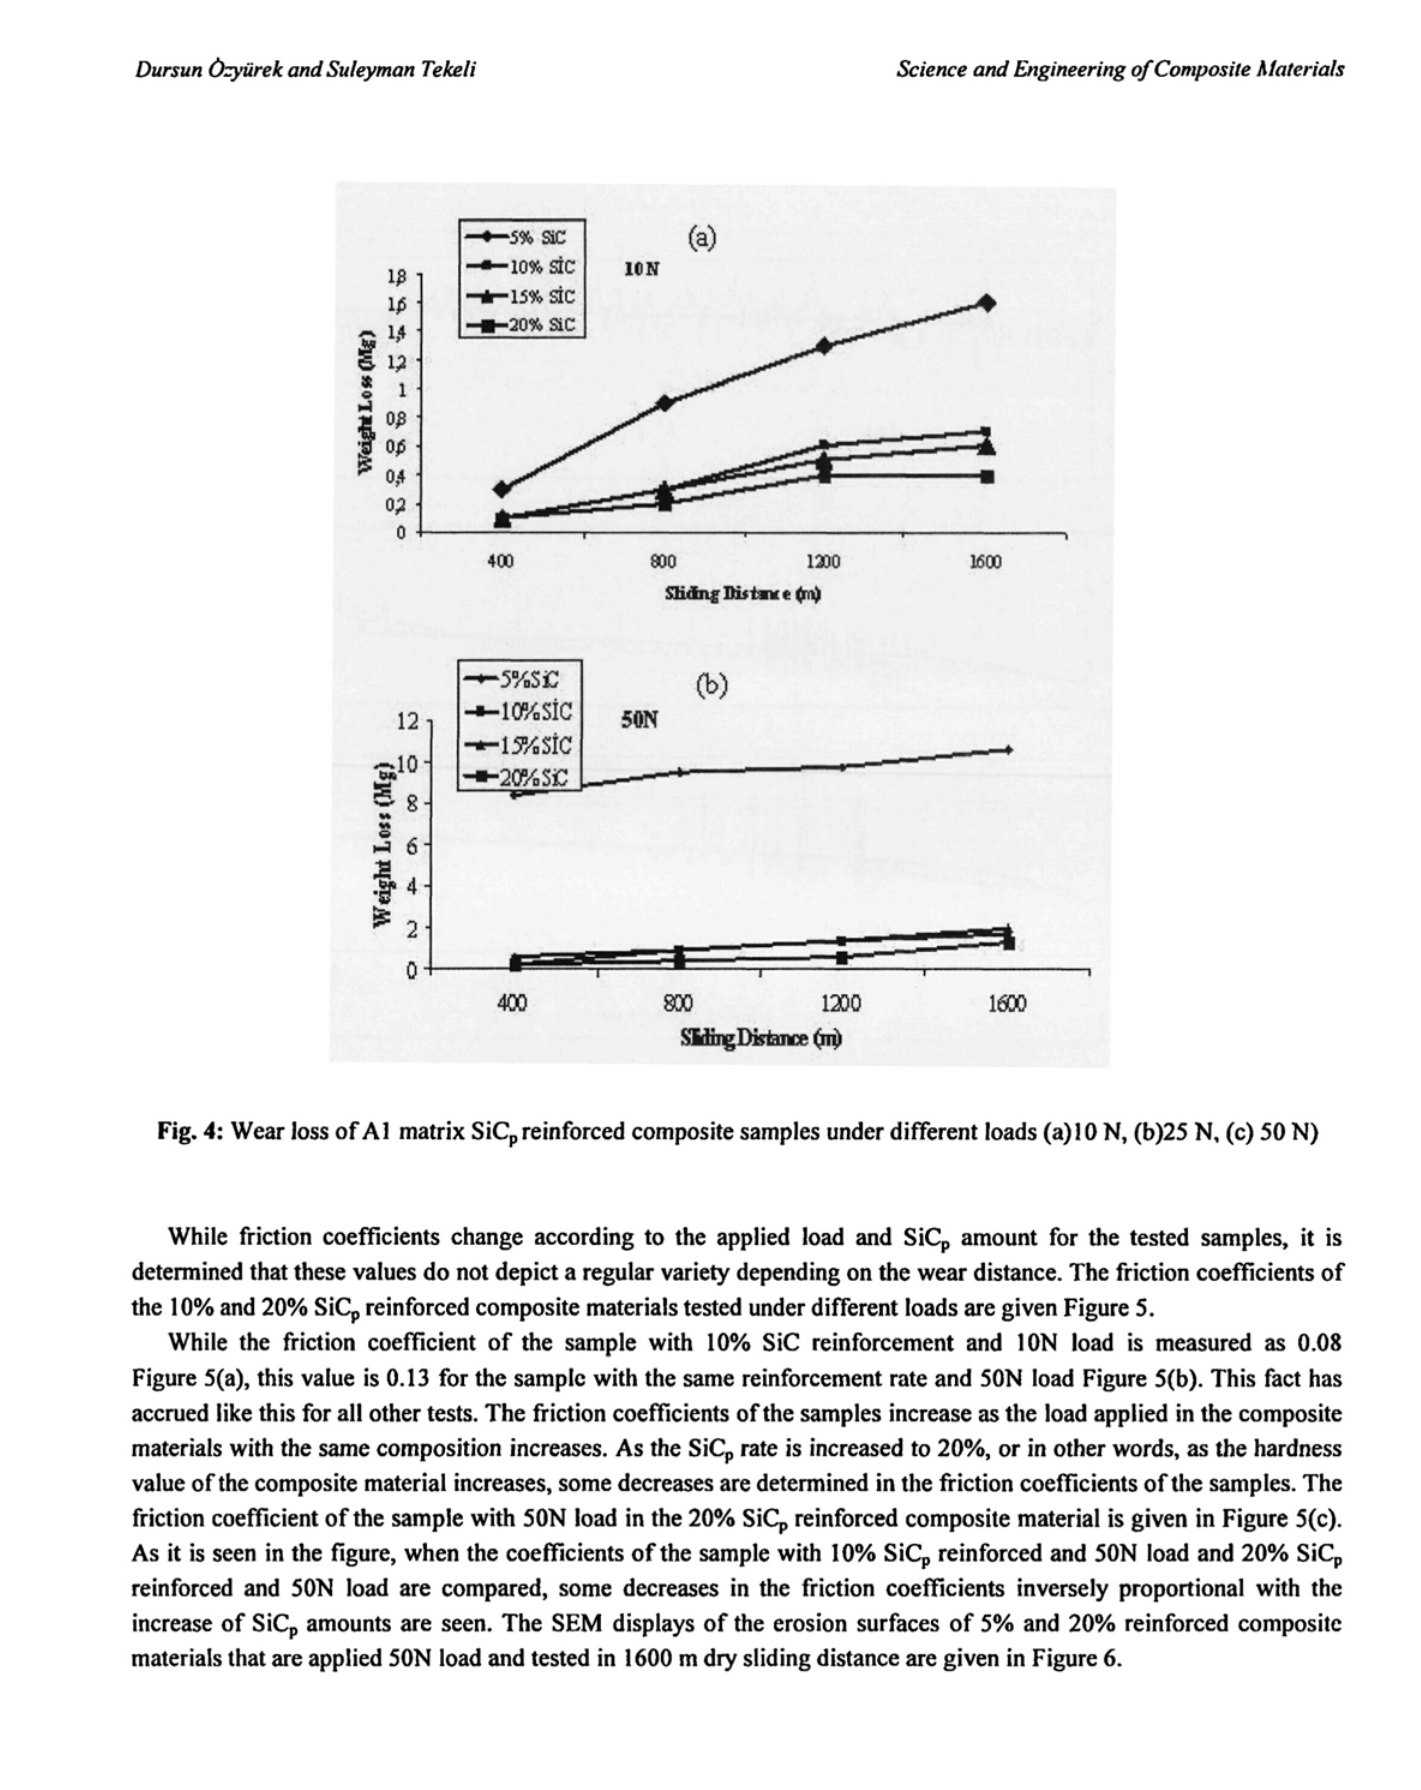
materials with the same composition increases. As the SiC rate is increased to 20%, or in other words, as the hardness p value of the composite material increases, some decreases are determined in the friction coefficients of the samples. The friction coefficient of the sample with SON load in the 20% SiC reinforced composite material is given in Figure 5(c). p As it is seen in the figure, when the coefficients of the sample with 10% SiC reinforced and SON load and 20% SiC p p reinforced and SON load are compared, some decreases in the friction coefficients inversely proportional with the increase of SiC amounts are seen. The SEM displays of the erosion surfaces of 5% and 20% reinforced composite p materials that are applied SON load and tested in 1600 m dry sliding distance are given in Figure